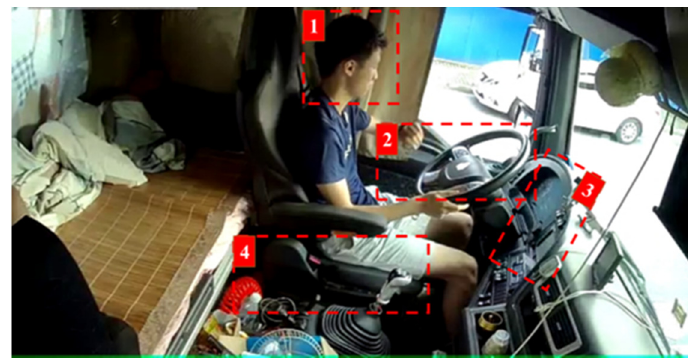
Figure 6. Selection of KA.